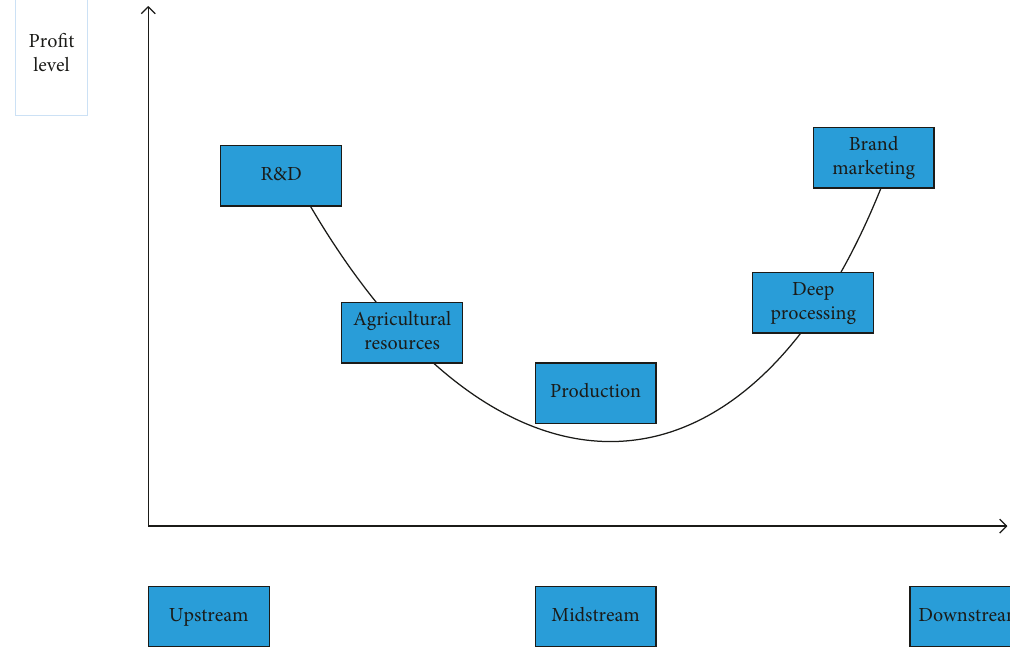
Figure 11: Smile curve of agricultural products supply chain.